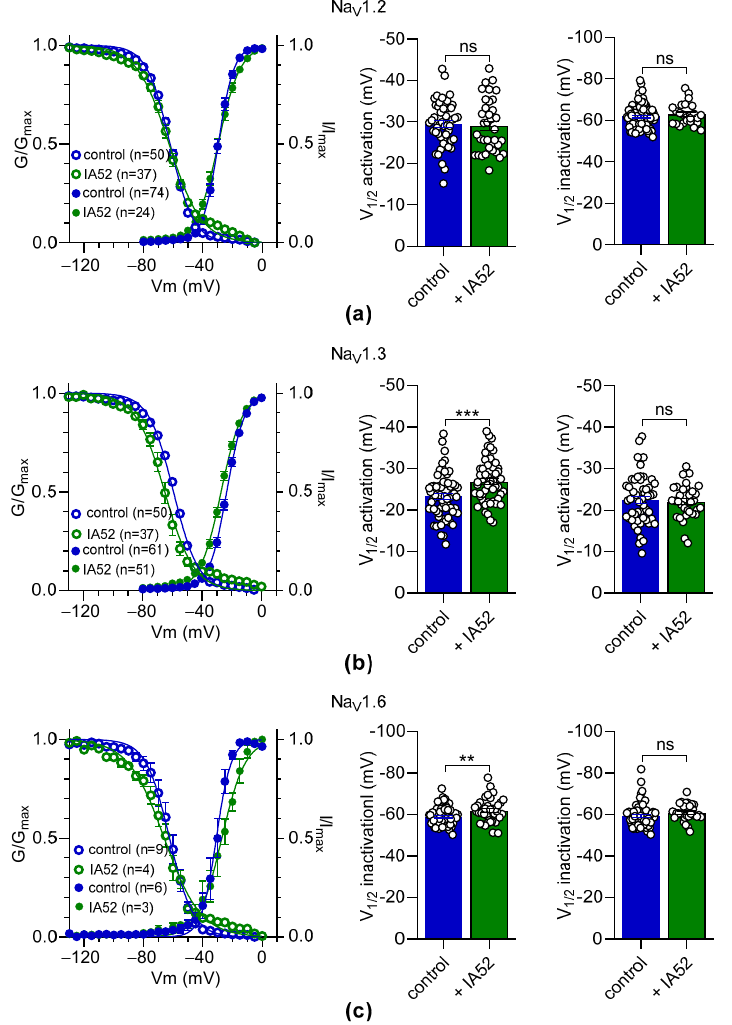
Figure 8. Effects of bebeerine on the activation and inactivation properties of Na + currents elicited by the hNa V 1.2, hNa V 1.3, and hNa V 1.6 channels. The effects of bebeerine (IA52, 10 µM) on the volt- age-dependent activation and inactivation of the hNa V 1.2 ( a ), hNa V 1.3 ( b ), and hNa V 1.6 ( c ) channels were evaluated. Right panels ( a – c ): Activation and inactivation curves show data that were fit with the Boltzmann equation. Middle and left panels: The scatter plots with bars show the V 1/2 of the voltage-dependent activation and inactivation of the hNa V 1.2 ( a ), hNa V 1.3 ( b ), and hNa V 1.6 ( c ) channels. Control exper- iments were performed with extracellular solution containing 0.1% of DMSO corresponding to the vehicle. Data are shown as mean ± SEM. An unpaired t -test was used to analyze the significance